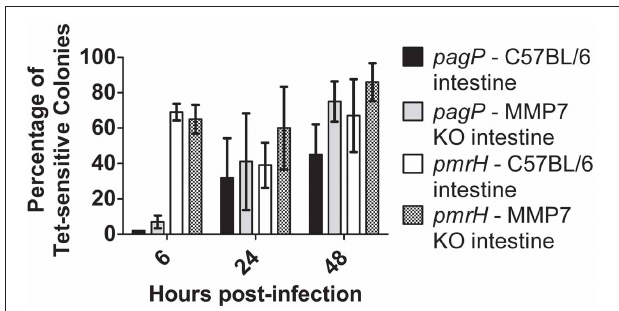
FIGURE 8 | TCRS-mediated activation of S . Typhimurium pagP and pmrH in the WT and Matrilysin-deficient murine intestine. C57BL/6 and MMP7 KO mice were infected orally with 10 8 CFU of the S. Typhimurium pagP and pmrH RIVET strains. Mice were sacrificed at 6, 24 and 48h p.i., for removal of two-three inches of the small intestine (measured from the distal ileum). Tissue samples were homogenized, diluted, plated on LB and grown overnight at 37 ◦ C to recover intracellular bacteria. One hundred colonies recovered from each sample were patched on LB and LB Tet to detect loss of Tet-resistance due to promoter activation in vivo . Graphed values represent the mean percentage ± standard deviation of Tet-sensitive colonies recovered from the intestine of three BALB/c and three CRAMP KO mice infected with the pagP or pmrH RIVET strain for each time point in one representative